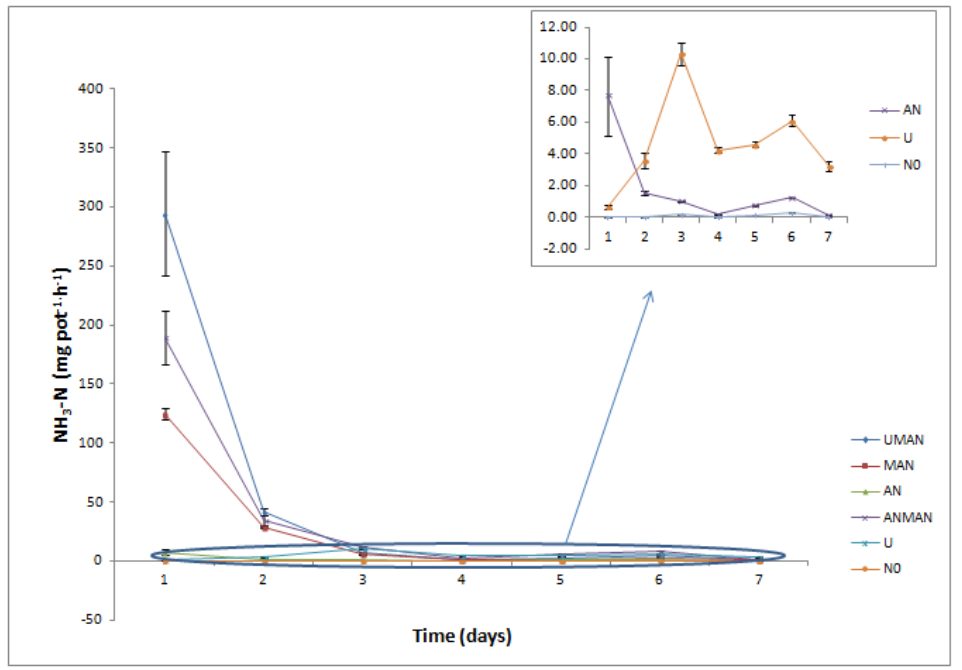
Figure 2. NH 3 –N daily emission rates (mg pot −1 h −1 ). Error bars represent the standard error values (mean, n = 3). U: Urea; AN: Calcium ammonium nitrate; MAN: Dairy manure; ANMAN: AN + MAN; UMAN: U + MAN; N0: Control.